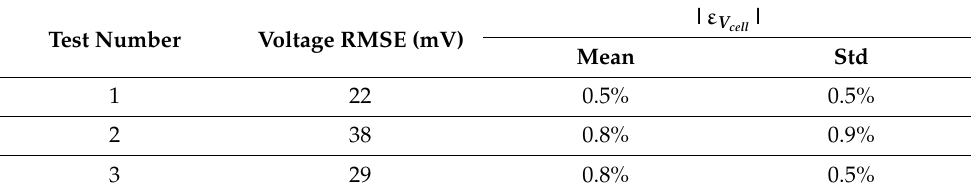
Table 7. Model voltage error in case of experimental electrode temperature taken as reference.